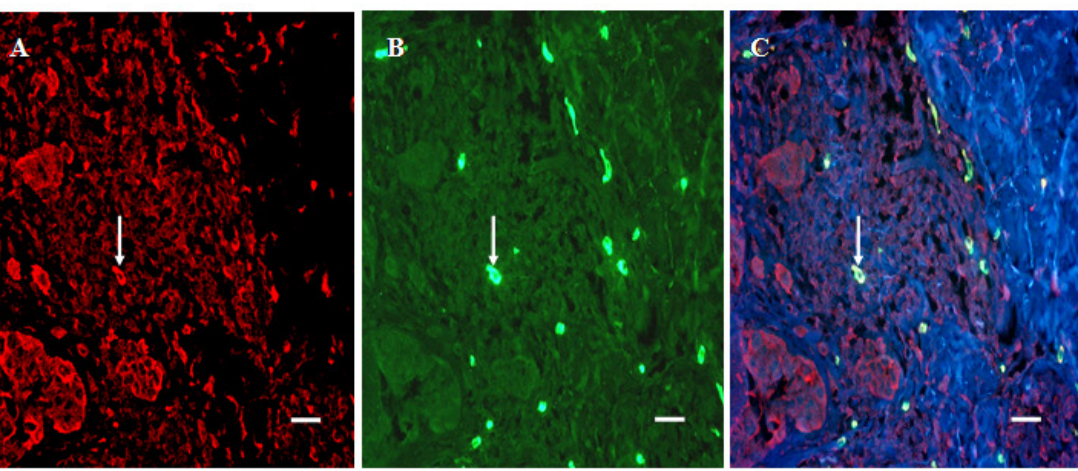
Figure 4. Double-staining of 5-HT1AR-positive inflammatory cells in the tumorous dermal region of SSM. (A) 5-HT1AR-positive cells (arrow,Texas Red). (B) tryptase- positive cells (arrow, FITC). (C) 5-HT1AR and tryptase (arrow). Bar is 20 µ